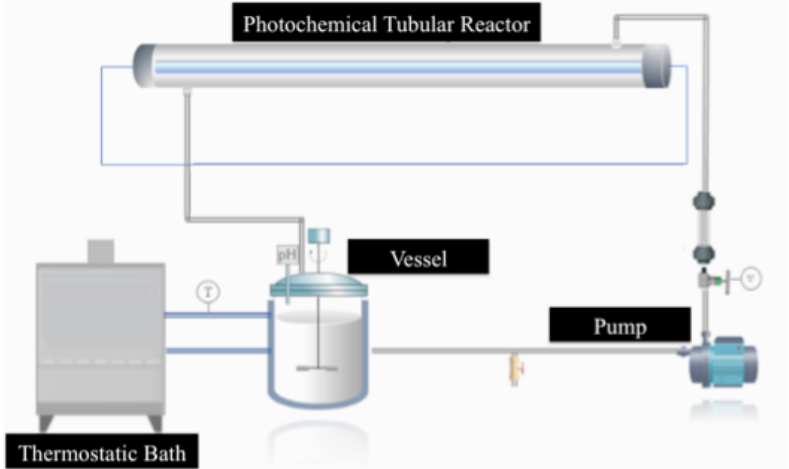
Figure 1. Simplified scheme of the experimental apparatus used in the photodegradation experiments.